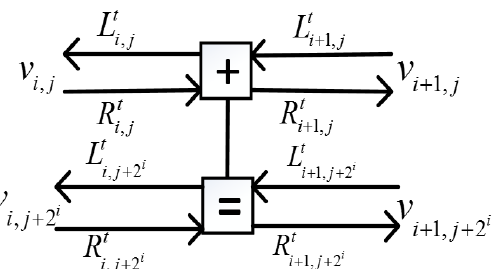
Figure 2. A 2-left-port 2-right-port basic computational block.